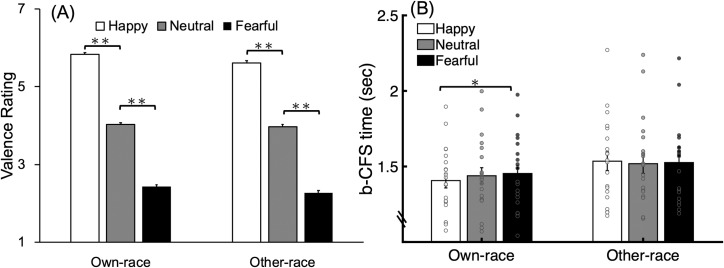
Results in Experiment 2.(A) Valence rating in the explicit emotion judgment task. Scale 1 referred to negative valence and scale 7 referred to positive valence. (B) Mean b-CFS time for detecting own-race and other-race faces with happy, neutral, and fearful facial expression. Error bars represent one standard error from the mean and the scatter plot represents the individual data. * p < .05; **p < .01.